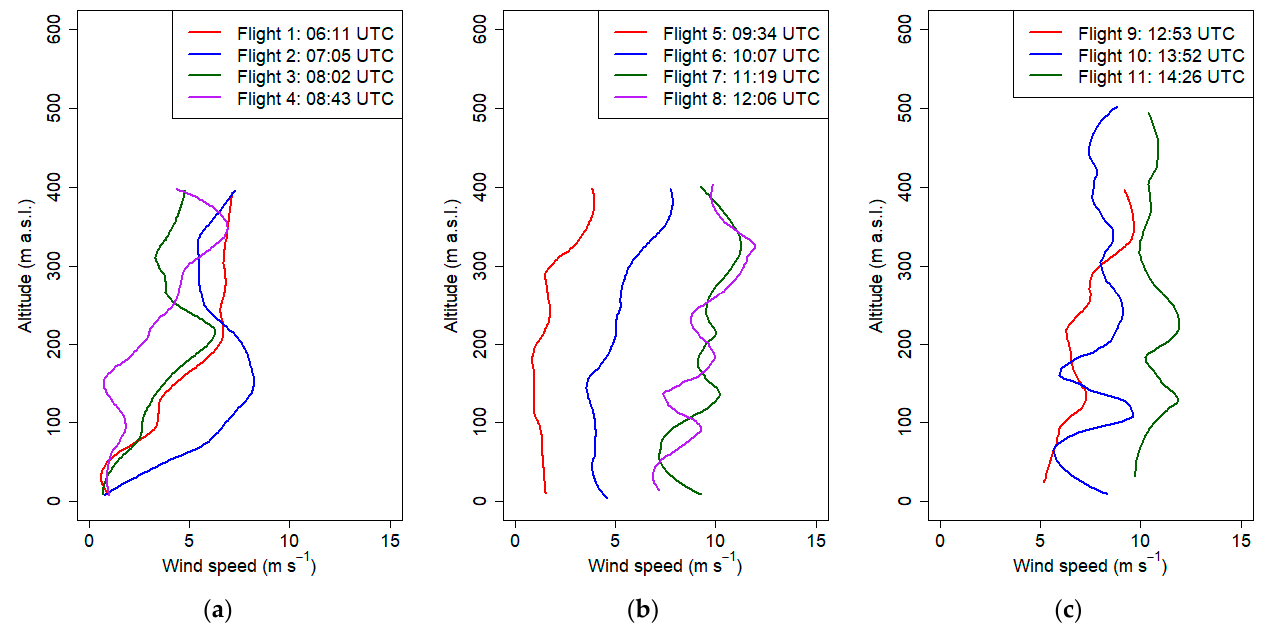
Figure 18. Vertical profiles of wind speed on March the 7th, 2019 from 6:00 UTC to 15:00 UTC. Figure 19 shows meteorological conditions at the JU Campus station on 7 March